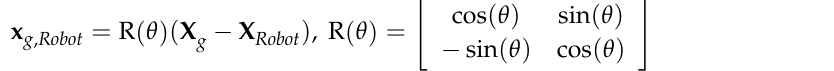
Figure 12. The smooth transition for redirecting the mobile robot from its current pose on current the streamline to a subgoal on the target streamline via pure pursuit.